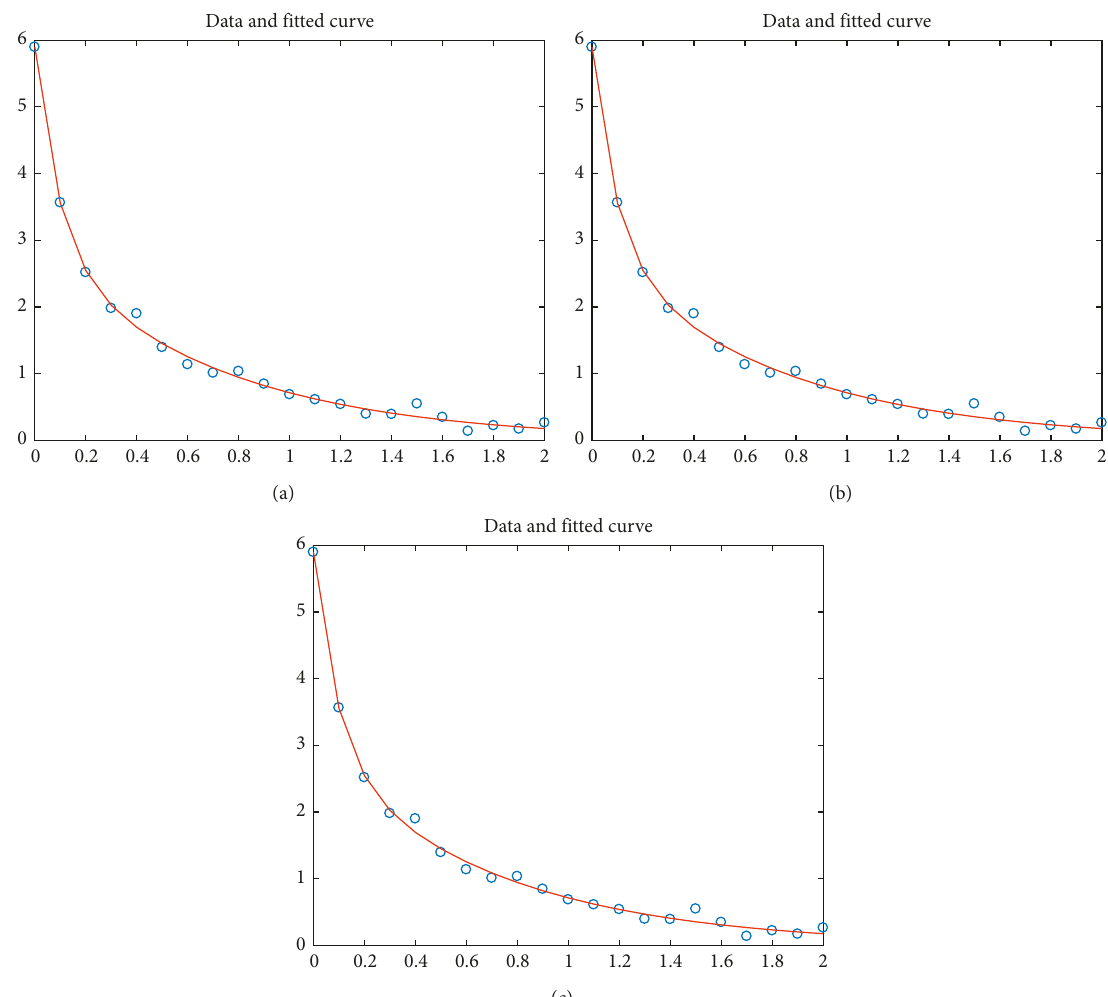
Figure 1: Observation data and fitting curves. (a) VP